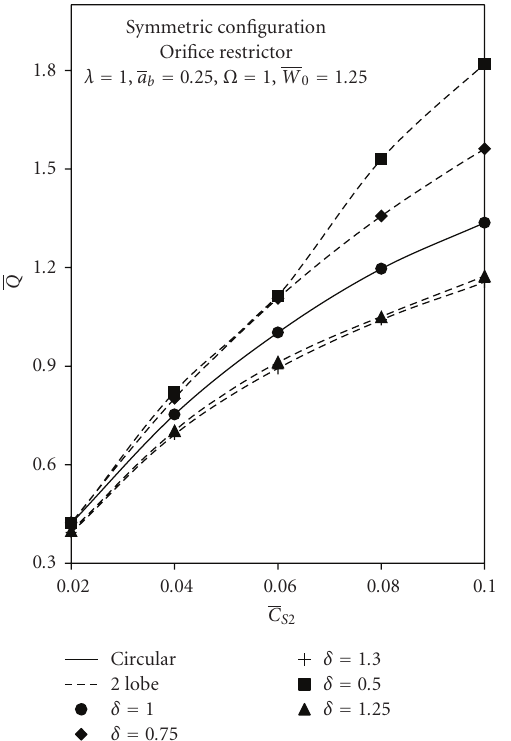
Figure 6: Variation of bearing flow ( Q ).